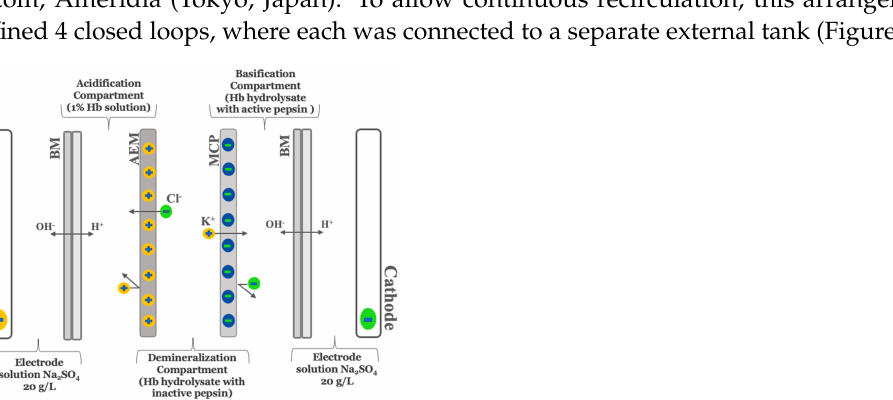
Figure 1. Schematic representation of three ‐ compartment bipolar membrane electrodialysis cell con ‐ figuration for production of demineralized and discolored–demineralized hemoglobin hydrolysates running simultaneously used by Abou ‐ Diab et al. [13]. BM, bipolar membrane; MCP, monovalent cation perm ‐ selective membrane; AEM, anion exchange membrane.